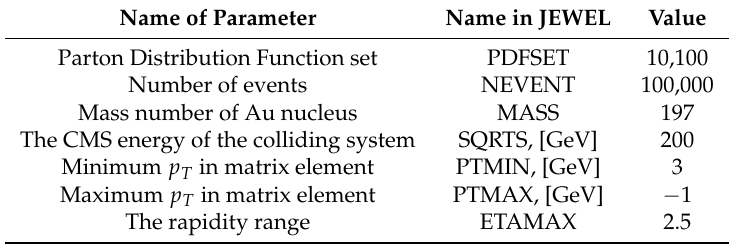
Table 1. Parameters of the JEWEL vacuum simulation for central and peripheral collisions [8]. Name of Parameter Name in JEWEL Value Parton Distribution Function set PDFSET 10,100